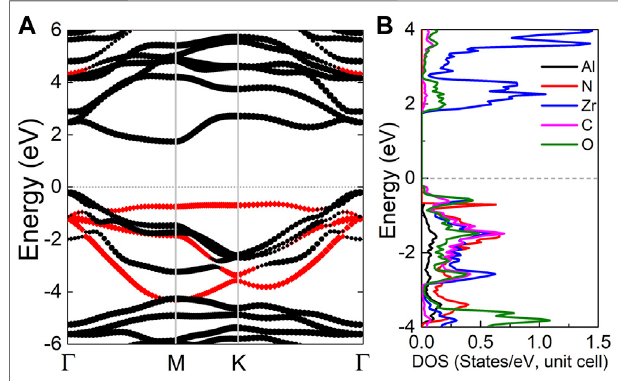
FIGURE 2 | (A) The projected band structure and (B) the partial density of states of the AlN/Zr 2 CO 2 vdW heterostructure, the Fermi level is expressed by 0 shown as dash